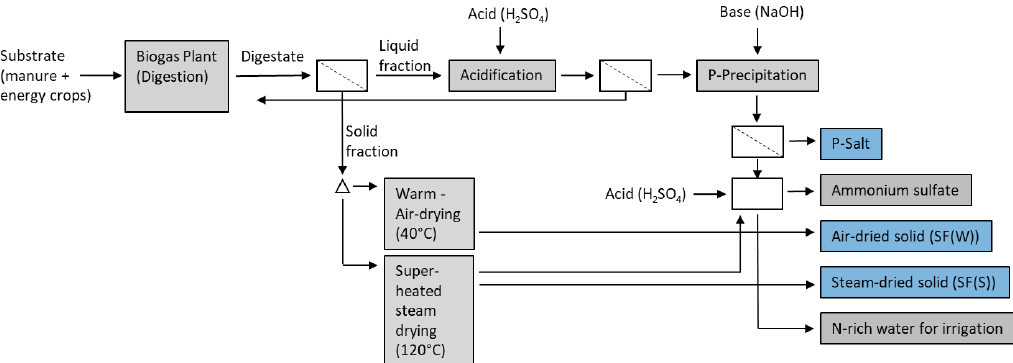
Figure 1. Overview of the recycling process of biogas digestates (according to [20]) to separate phosphate salts (P-Salts) from the liquid phase and to convert the solid digestate fraction into dried solids (SF (W/S) (blue boxes). All rights on this recycling process belongs to Fraunhofer IGB, Stuttgart, Germany [21]. Table 1. Characteristics of phosphate salt (P-Salt) and solids.